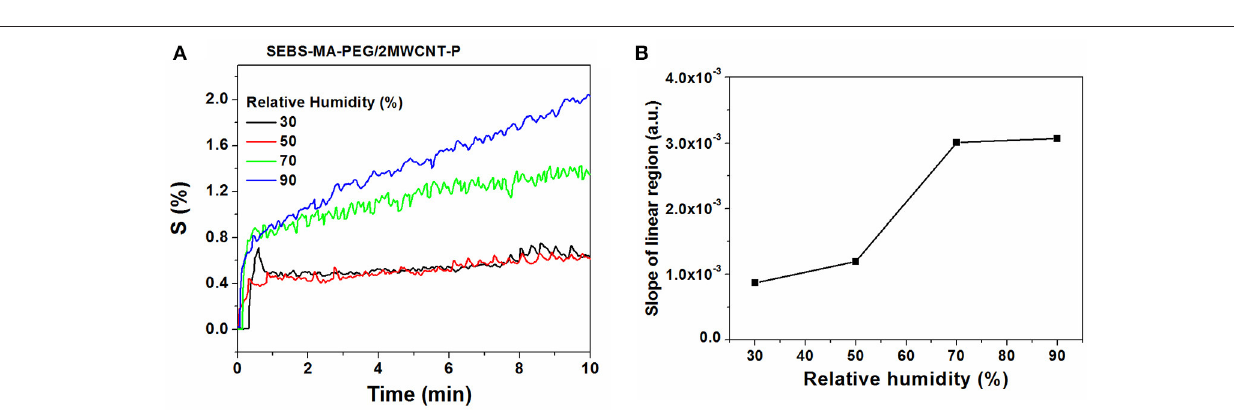
Frontiers in Materials |